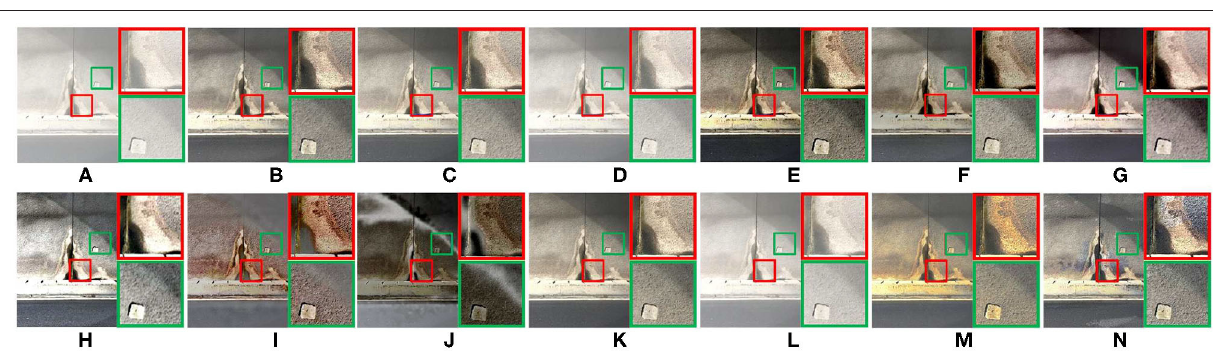
The high PSNR value means less distortion of defogging